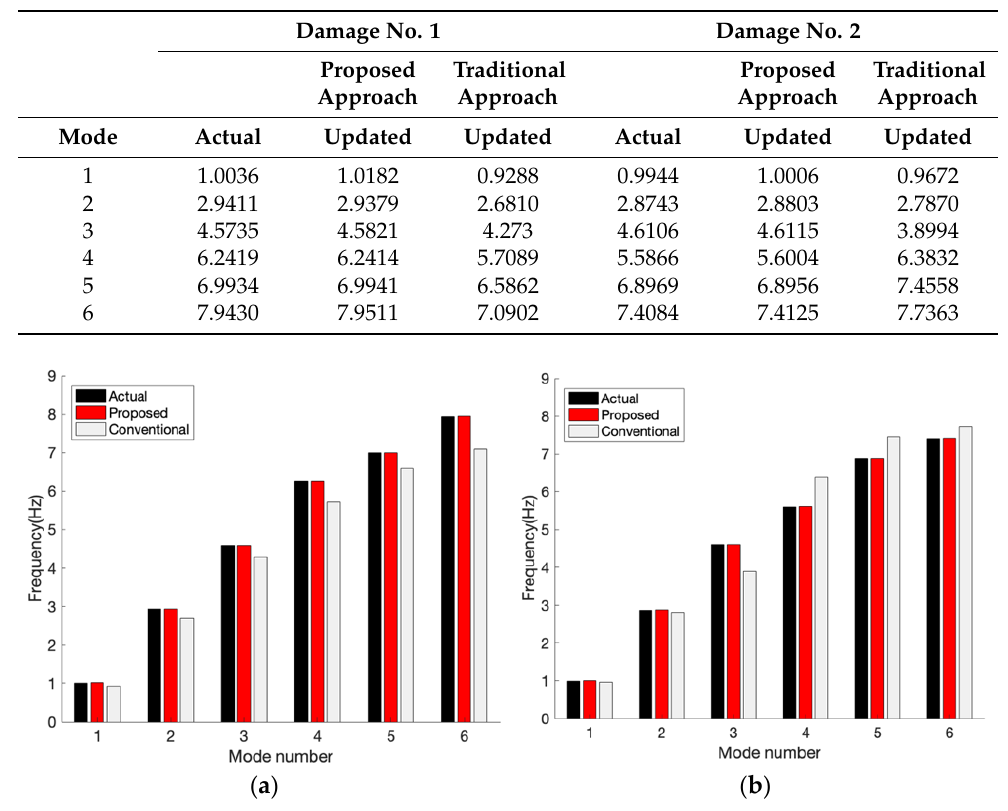
Table 4. Frequencies’ (Hz) comparison by the proposed and traditional approach.